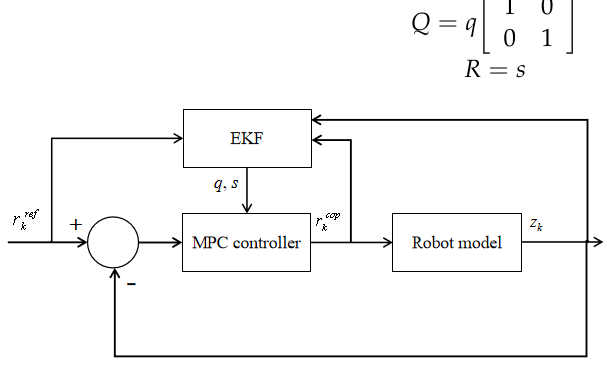
Figure 5. The combination of MPC and EKF.